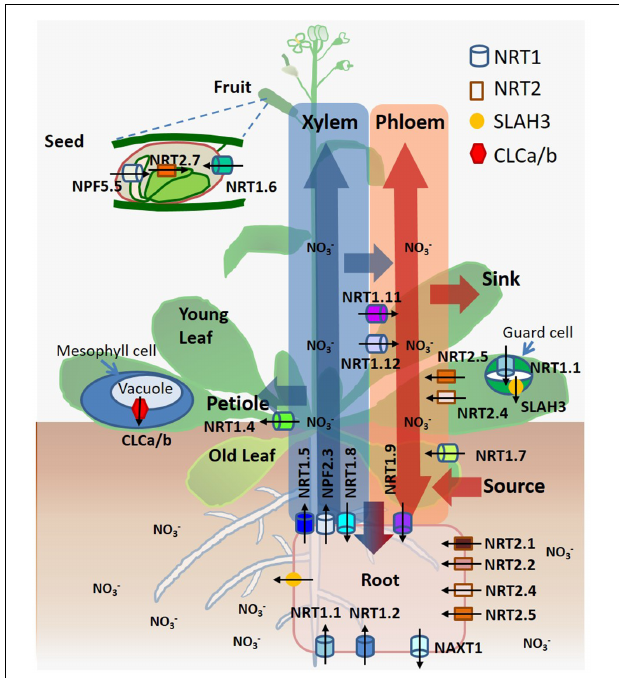
FIGURE 1 | A summary of spatiotemporal functionality of nitrate transporters/channels and nitrate transport routes in Arabidopsis . Nitrate is taken up by roots, loaded/unloaded by xylem and phloem, and transported to leaves, shoots and seeds. Arrows indicate the directions of nitrate movement. Transporters and channels are depicted according to their